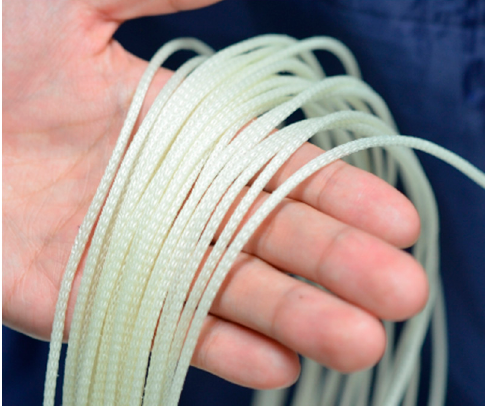
Figure 1. The thin McKibben artificial muscle.